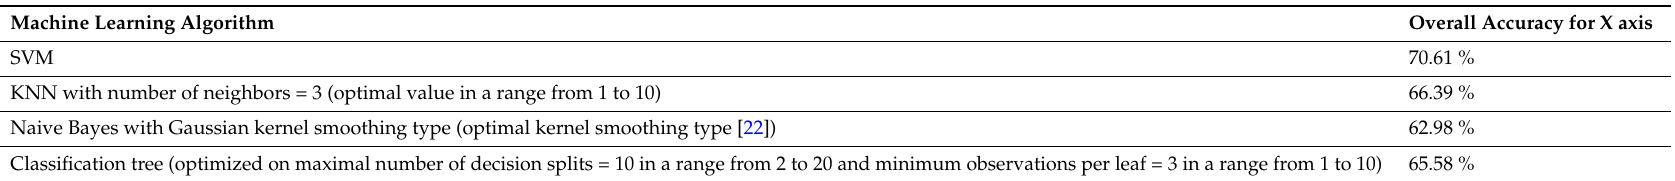
Table 6. Comparison among the different machine learning algorithms for the digital output generated by the magnetometer on the X axis. Accuracy values have been averaged over the 50